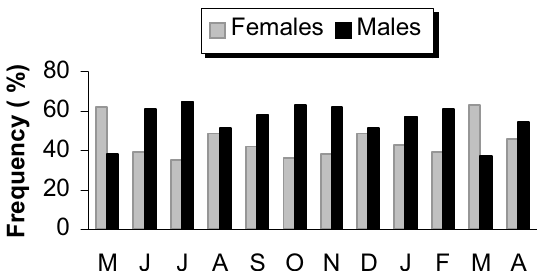
Fig. 8. Monthly variation of relative frequencies of males and females of Gymnotus aff. carapo in lagoa Verde, Itapuã State Park.